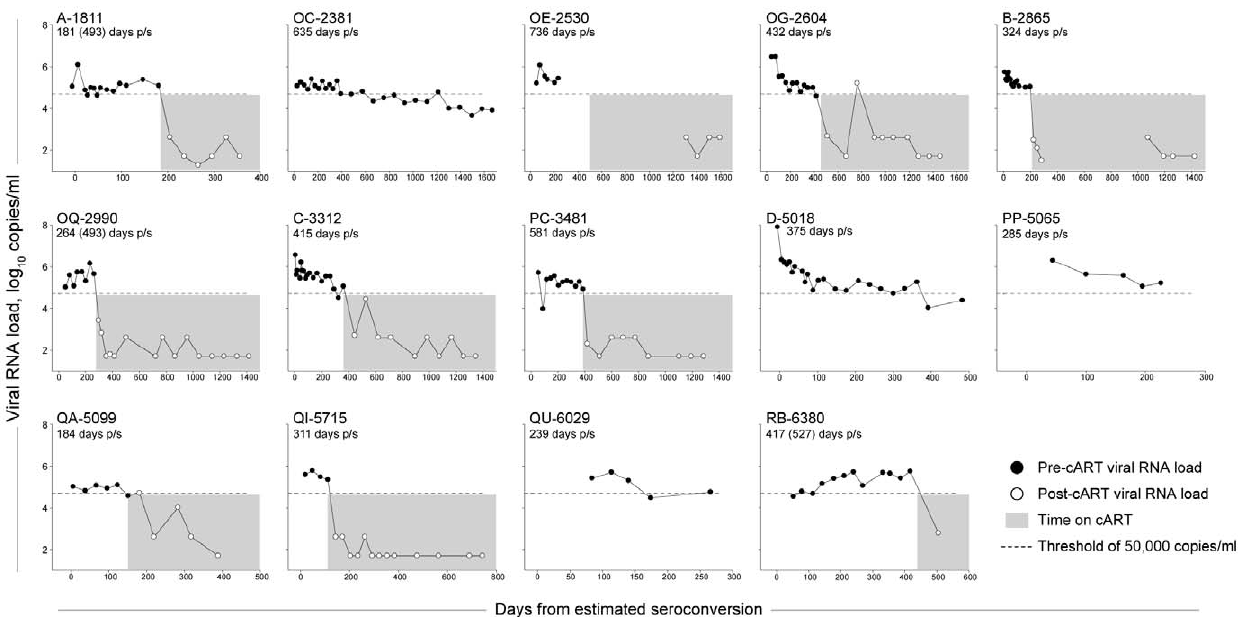
Figure 4. Dynamics of HIV-1 RNA levels in subjects with high early viral set point, n=14. High HIV RNA level was considered at $ 50,000 (4.7 log 10 ) copies/ml. Early viral set point was determined as a mean value from 50 to 200 days p/s. Data for each subject is presented in a separate graph. Patient code is shown at the top left of each graph. Y-axis shows HIV-1 RNA levels, log 10 copies/ml; scale is uniform for all subjects; the 50,000 (4.7 log 10 ) copy threshold is shown as a dashed line. X-axis denotes days from estimated seroconversion; scale differs between subjects due to differences in the follow-up period. Filled circles delineate pre-cART HIV-1 RNA values, and open circles show post-cART HIV-1 RNA values. Time of cART is highlighted by gray zone, if applicable. For calculation of slopes and prediction of time of decline to the threshold of 50,000 (4.7 log 10 ) copies, only pre-cART data were used. The conservative estimate of individual time to decline below 50,000 (4.7 log 10 ) copies is shown under the patient code with the less conservative Kaplan-Meier estimate in brackets (if it differs from the conservative estimate).